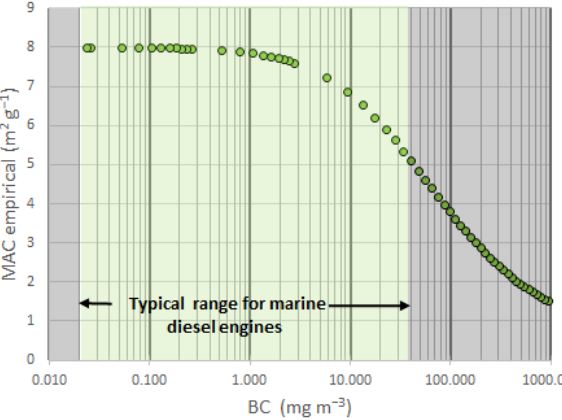
Figure 1. MAC BC at 550–570 nm as a function of BC concentrations calculated via ratio of sample volume and an effective cross-section area of a filter and reflectometer voltages converted to a blackening (absorbance) fraction scaled to equation of BC concentrations including thermophoretic loss correction.